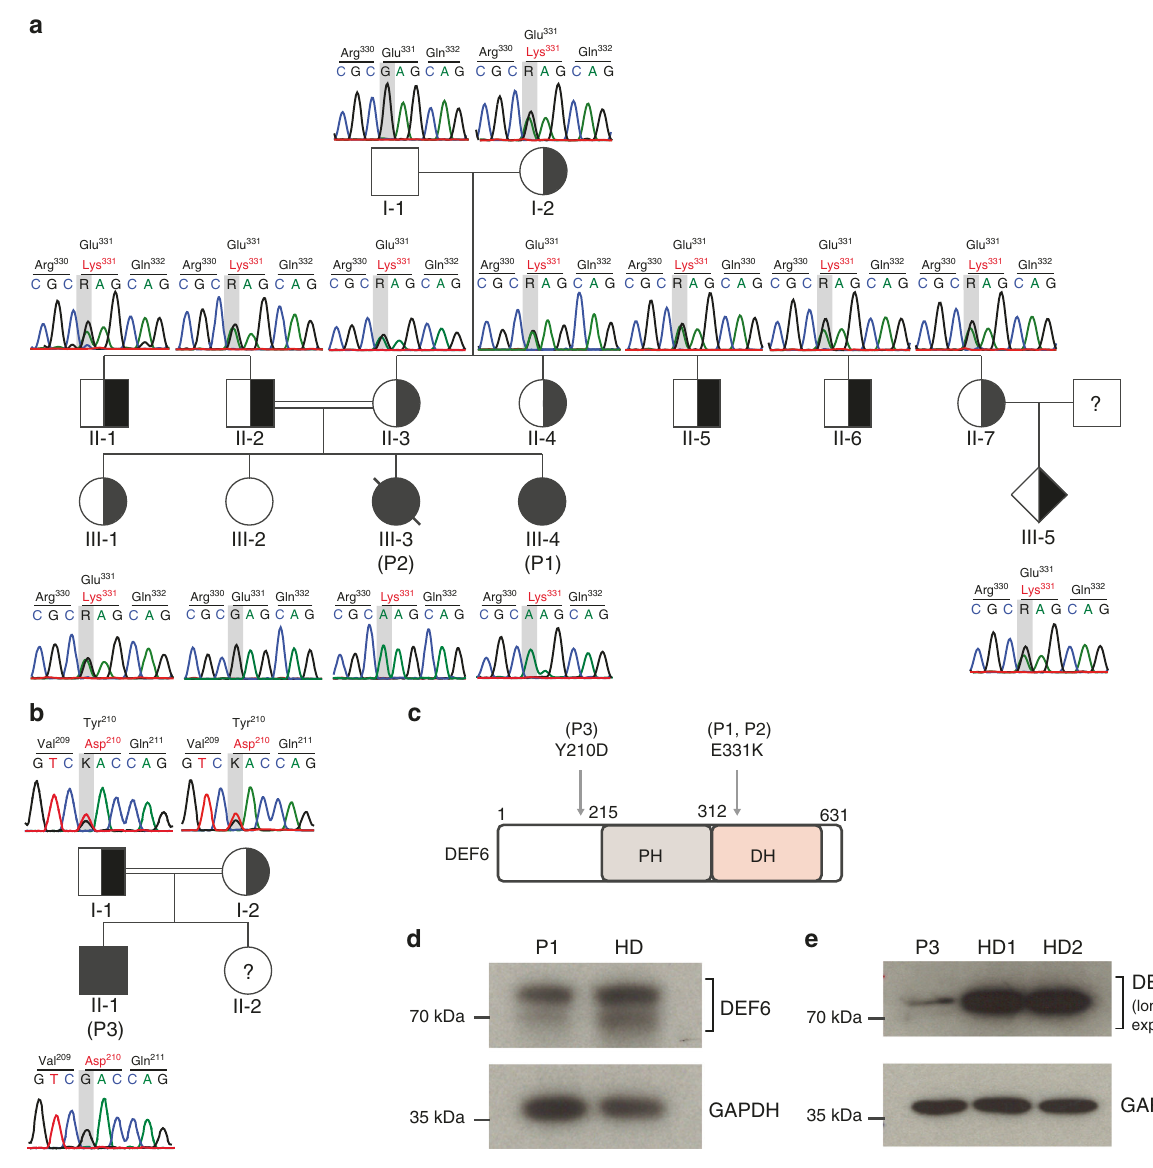
Fig. 2 Distinct biallelic DEF6 mutations segregate with disease. a, b Segregation pedigrees and chromatograms of the identi fi ed DEF6 mutations in family A (a, variant c.G991A) and family B (b, variant c.T628G). All depicted individuals were validated by capillary sequencing. Un fi lled – wild type; fi lled – homozygous mutation; half fi lled – heterozygous state.? – unknown genetic state (not sequenced). For information on the variants, see Supplementary Table S1. c Schematic of DEF6 protein domains indicating the identi fi ed mutations. PH – Pleckstrin homology domain; DH – Dbl homology domain. d DEF6 E331K mutant protein expression is partially reduced in feeder-expanded T cells of P1. e DEF6 Y210D mutant protein is barely detectable in T cells of P3 (long exposure is shown). Shorter-exposed immunoblots for ( e ) are shown in Supplementary Figure S2a. Immunoblots for ( d ) and ( e ) were cropped for visualization and are representative of two independent experiments. Source data of Fig. 2 including uncropped immunoblots are provided as a Supplementary Source Data fi